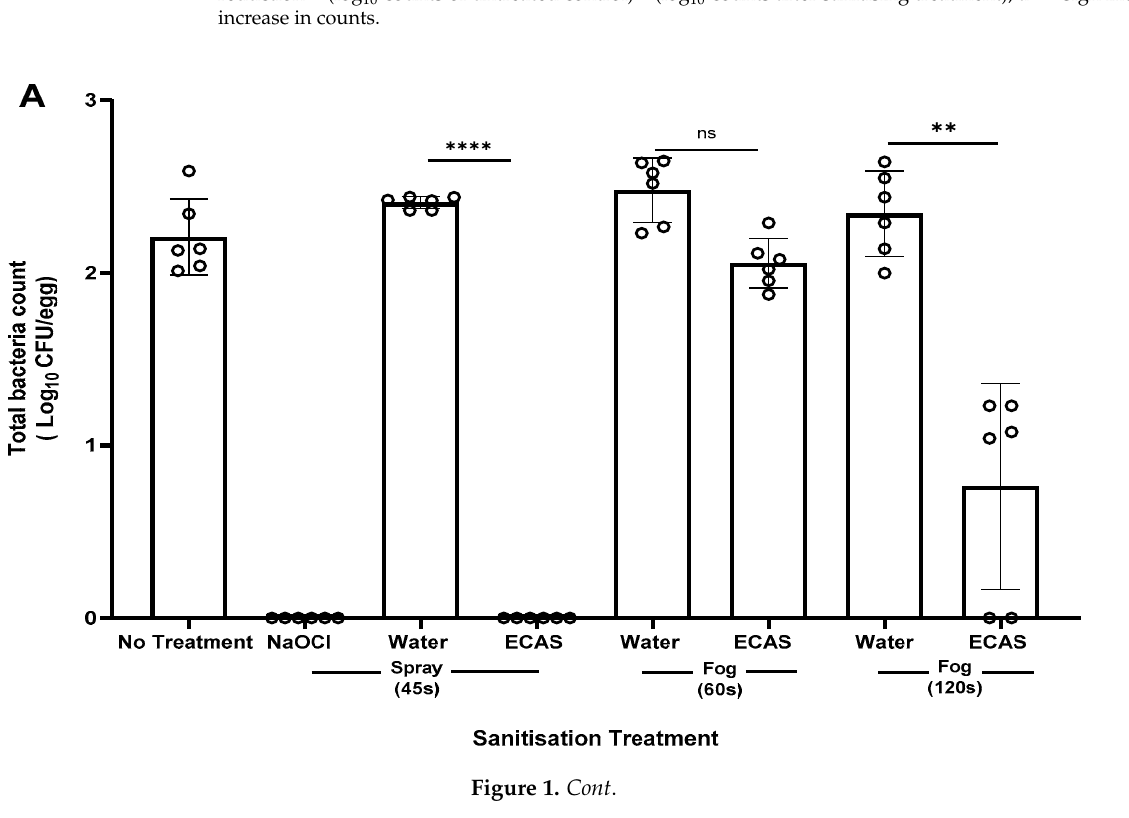
Figure 1. Effectiveness of sprayed and aerosolised ECAS on reduction of total bacterial load on egg surface. ( A ) Total bacterial load after the various sanitisation treatments. ( B ) Aerosolised ECAS sanitisation of individual (one egg/tray) and simultaneous (three eggs/tray) treated eggs for 60s and 120s. NaOCl—sodium hypochlorite (~200 mg/L FAC); ECAS— electrochemically activated solution (150 mg/L of FAC); ns—not significant; ** p < 0.01, **** p < 0.0001. The effectiveness of aerosolised ECAS was further assessed when the eggs were san- itised simultaneously (three eggs/tray) or individually (one egg/tray) for 60s and 120s, respectively. Aerosolised ECAS (120s) significantly reduced the total bacteria load for both one egg/tray ( p < 0.0001) and three eggs/tray ( p < 0.01; Figure 1B). The treatment of three eggs/tray with aerosolised ECAS (120s) did not eliminate the total bacterial load completely; however, the level was not significantly different from the treatment of one egg/tray aerosolised ECAS (120s) (Figure 1B).